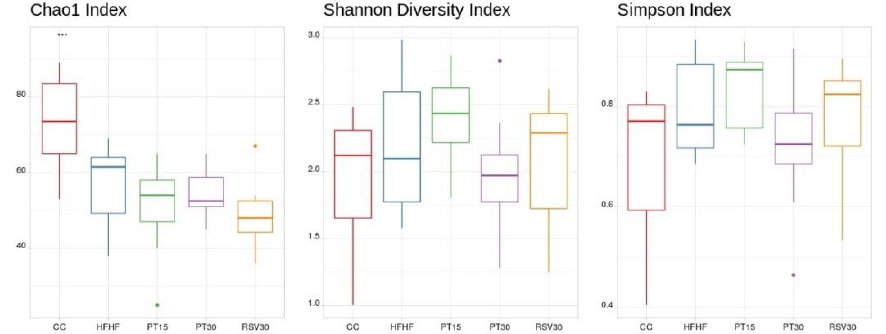
Figure 2. Representative H&E-stained histological liver samples (magnification ×20). ( A ) Healthy liver from CC group, ( B ) liver from HFHF group showing moderate inflammation and ballooning degeneration, ( C ) liver from PT30 group showing mild inflammation and ballooning degeneration and ( D ) liver from RSV30 group showing mild–moderate inflammation and ballooning degeneration. White arrows indicate inflammation. Ballooned cells are identified by the larger size of their wispy cleared cytoplasm.